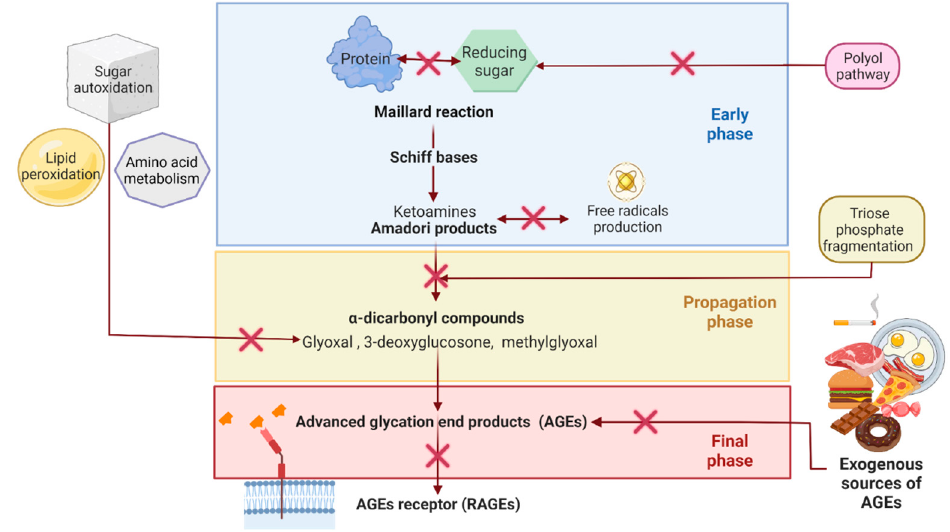
Figure 3. The mechanisms of action of antiAGEs compounds. The antiAGEs compounds could restrict in different ways, shown with a red cross, the undue accumulation, and consequent harmful effects of AGEs. These compounds may block sugar attachment to proteins, scavenge free radicals, chelate ions, trap reactive dicarbonyl species, break AGEs cross-links, or block the AGEs–RAGEs interaction. Hyperglycemic control and inhibition of aldose reductase or sorbitol dehydrogenase may decrease the reducing sugars available and, therefore, the formation of AGEs. Created with Biorender.com.